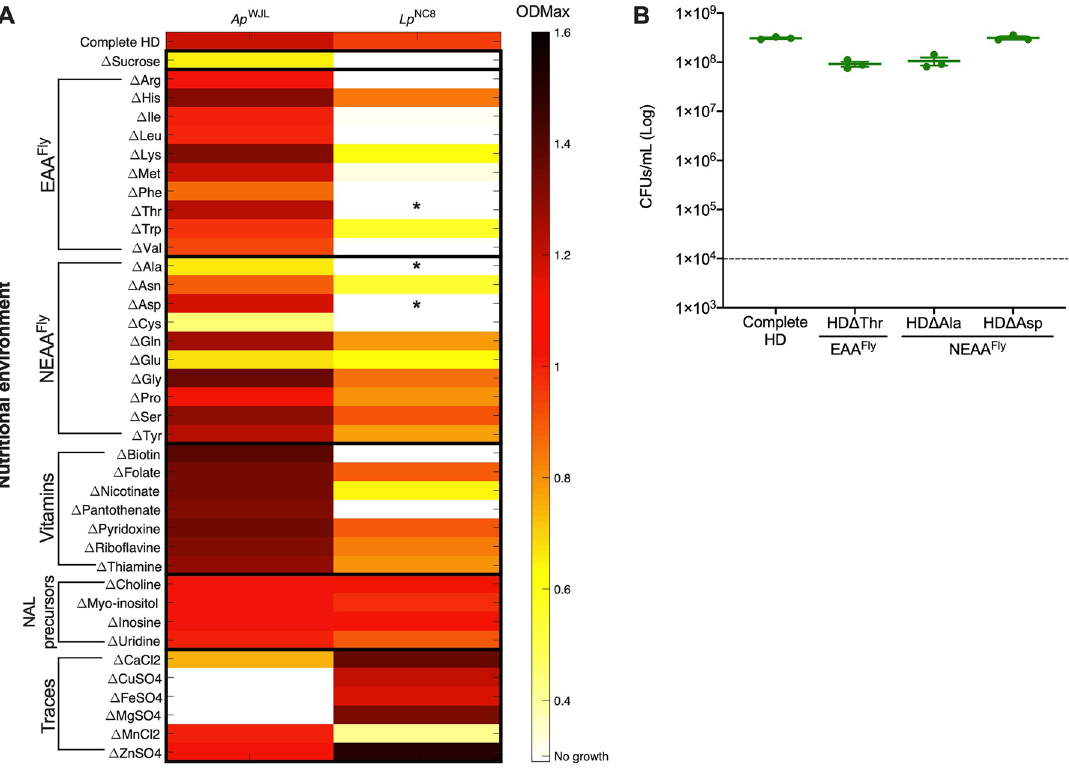
Fig 3. Ap WJL and Lp NC8 auxotrophies detected in liquid fly HD. (A) Heat map representing the mean OD Max reached by Ap WJL or Lp NC8 after 72 h of culture. Each line shows growth in a different version of the liquid HD: complete HD (first line) or HD lacking nutrient X ( Δ X, lines below). Cultures were made in 96-well plates under agitation. Asterisks ( � ) pinpoint contradictions with our metabolic pathway automated annotations, which are explained in panel B. (B) Growth of Lp NC8 in 4 versions of liquid HD: complete HD, HD Δ Thr, HD Δ Ala, and HD Δ Asp in static conditions. Plot shows means with standard error based on 3 replicates by assay. Each dot represents an independent replicate. The dashed line represents the level of inoculation at t = 0 h (10 4 CFUs per mL). Ap WJL , A . pomorum WJL ; CFU, colony-forming unit; EAA Fly , fly essential amino acid; HD, Holidic Diet; Lp NC8 , L . plantarum NC8 ; NALs, nucleic acids and lipids; NEAA FLY , fly nonessential amino acid; OD Max , maximal optical density.